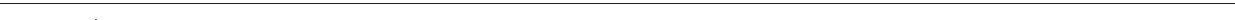
FIGURE 2 | Three independent experimental series were performed with six animals per group in each series. Data were represented as mean ± SD ( n = 6). (A) The mRNA level of IL-9 in the kidneys in each treatment group. Dot plots show the corresponding quantification of mRNA level and fold change. *** P < 0.001 vs. the vehicle group. ### P < 0.001 vs. the CP group. (B) Changes in the serum creatinine (Cr) level with each treatment group. *** P < 0.001 vs. the vehicle group; ### P < 0.001 vs. the CP group. (C) Changes in the serum blood urea nitrogen (BUN) levels with each treatment group. *** P < 0.001 vs. the vehicle group; ### P < 0.001 vs. the CP group. (D) Changes in the creatinine clearance rate (CCr) level with each treatment group. *** P < 0.001, * P < 0.05 vs. the vehicle group; ### P < 0.001 vs. the CP group. (E) Western blot was performed on different treatment groups to determine the kidney injury molecule-1 (KIM-1) expressions. Each lane represents one sample from an individual mouse. Dot plots showed the corresponding quantification of band intensity and fold change. *** P < 0.001, ** P < 0.01 vs. the vehicle group; ### P < 0.001 vs. the CP group. (F) Representative images of H&E staining of the kidney section of the different groups of mice after 72h of CP injection. Magnification: × 10 and × 40. (G) Body weight of mice in each group after 72h of CP injection. *** P < 0.001 vs. the vehicle group. ### P < 0.001 vs. the CP group. (H) The level of pro-inflammatory cytokine tumor necrosis factor- α (TNF- α ) in the serum of mice from each group after 72h of CP injection. ** P < 0.01 vs. the vehicle group; ### P < 0.001 vs. the CP group. (I) The level of pro-inflammatory cytokine interleukin-6 (IL-6) in the serum of mice from each group after 72h of CP injection. *** P < 0.001 vs. the vehicle group; ### P < 0.001 vs. the CP